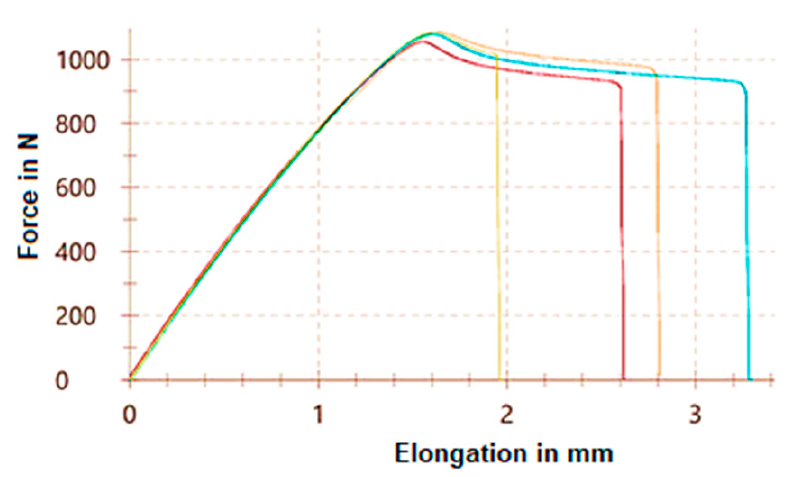
Figure 6. Tensile curves of the horizontally orientated test specimens. In the case of the horizontal orientation, the average tensile strength was 51.25 MPa, and in the case of the vertical printing orientation, it was 35.6 MPa.